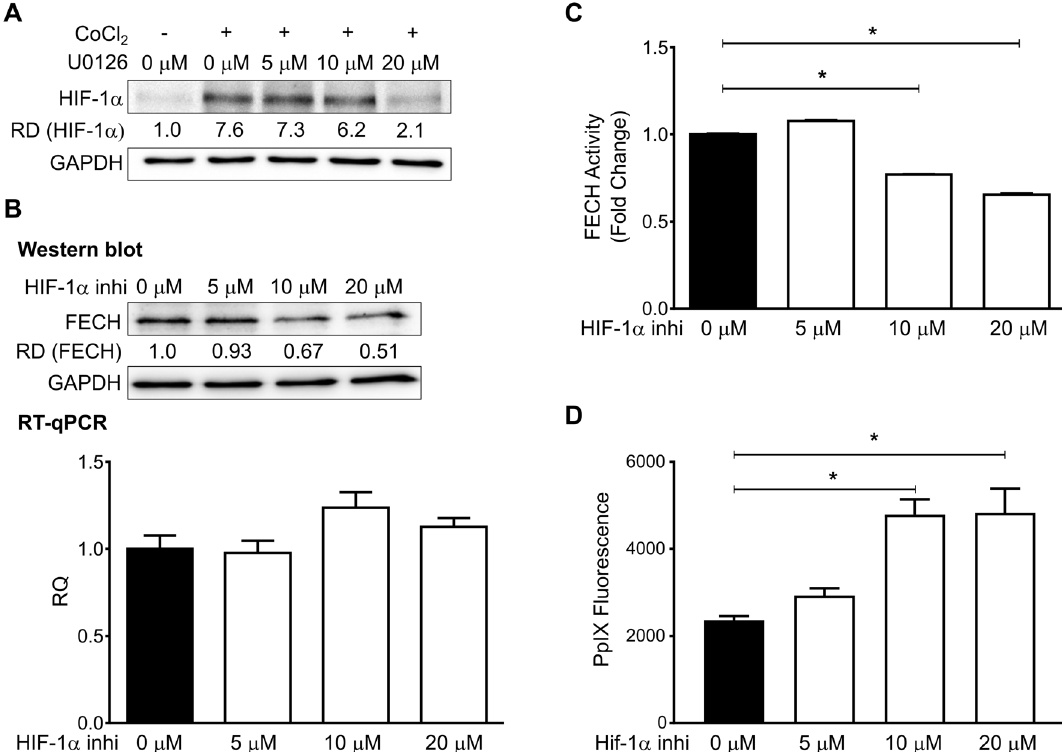
Figure 6. Oncogenic Ras regulates FECH activity via HIF-1α. ( A ) Representative western blot showing HIF-1α expression in RasV12 cells treated with or without CoCl 2 and different concentrations of U0126. The relative band densities (RD) are indicated. ( B ) Protein (Top) and mRNA (Bottom) levels of FECH in RasV12 cells treated with different concentrations of HIF-1α inhibitor. The relative band densities (RD) are indicated. RQ: relative quantification. ( C , D ) Mean ± SD fold change in FECH activity ( C ) mean ± SD PpIX fluorescence ( D ) in RAS V12 cell lysates treated with different concentrations of HIF-1α inhibitor from 3 independent experiments. *p < 0.01 by one-way ANOVA with Turkey’s posthoc